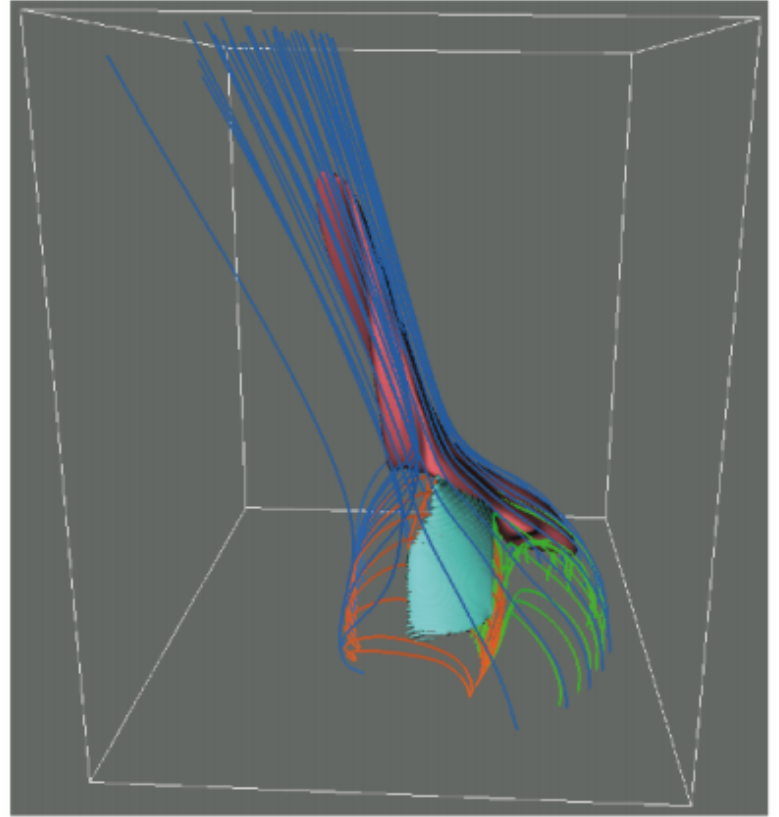
Figure 50: 3D visualization of the MHD simulation of an emerging twisted flux tube and pre-existing oblique field by Moreno-Insertis et al. (2008). The orange, blue, and green lines indicate the field lines in the emerging flux, the pre-existing field, and the reconnected field, respectively. The red and blue isosurfaces are that of temperature ( 𝑇 = 6.5 MK) and 𝐽/𝐵 (blue), respectively. Image reproduced with permission, copyright by